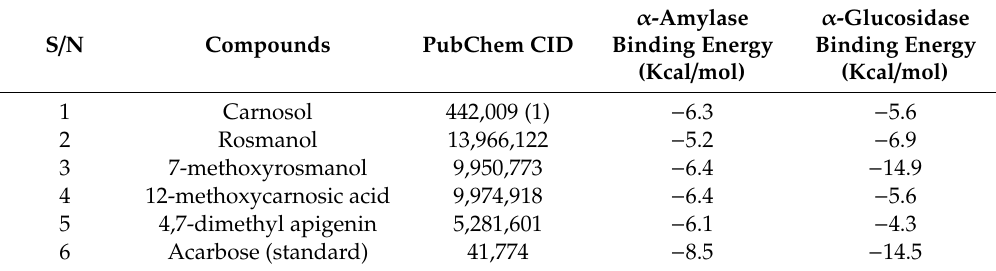
Table 2. Binding energy of interactions between compounds and enzymes (alpha-amylase and alpha-glucosidase).